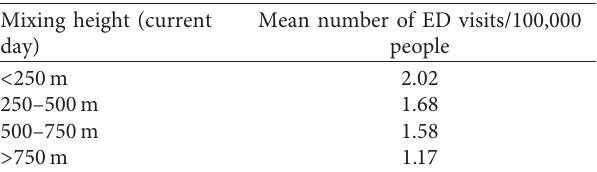
Table 2: Lower median daily mixing height associated with greater proportion of population-adjusted pediatric emergency depart- ment visits for